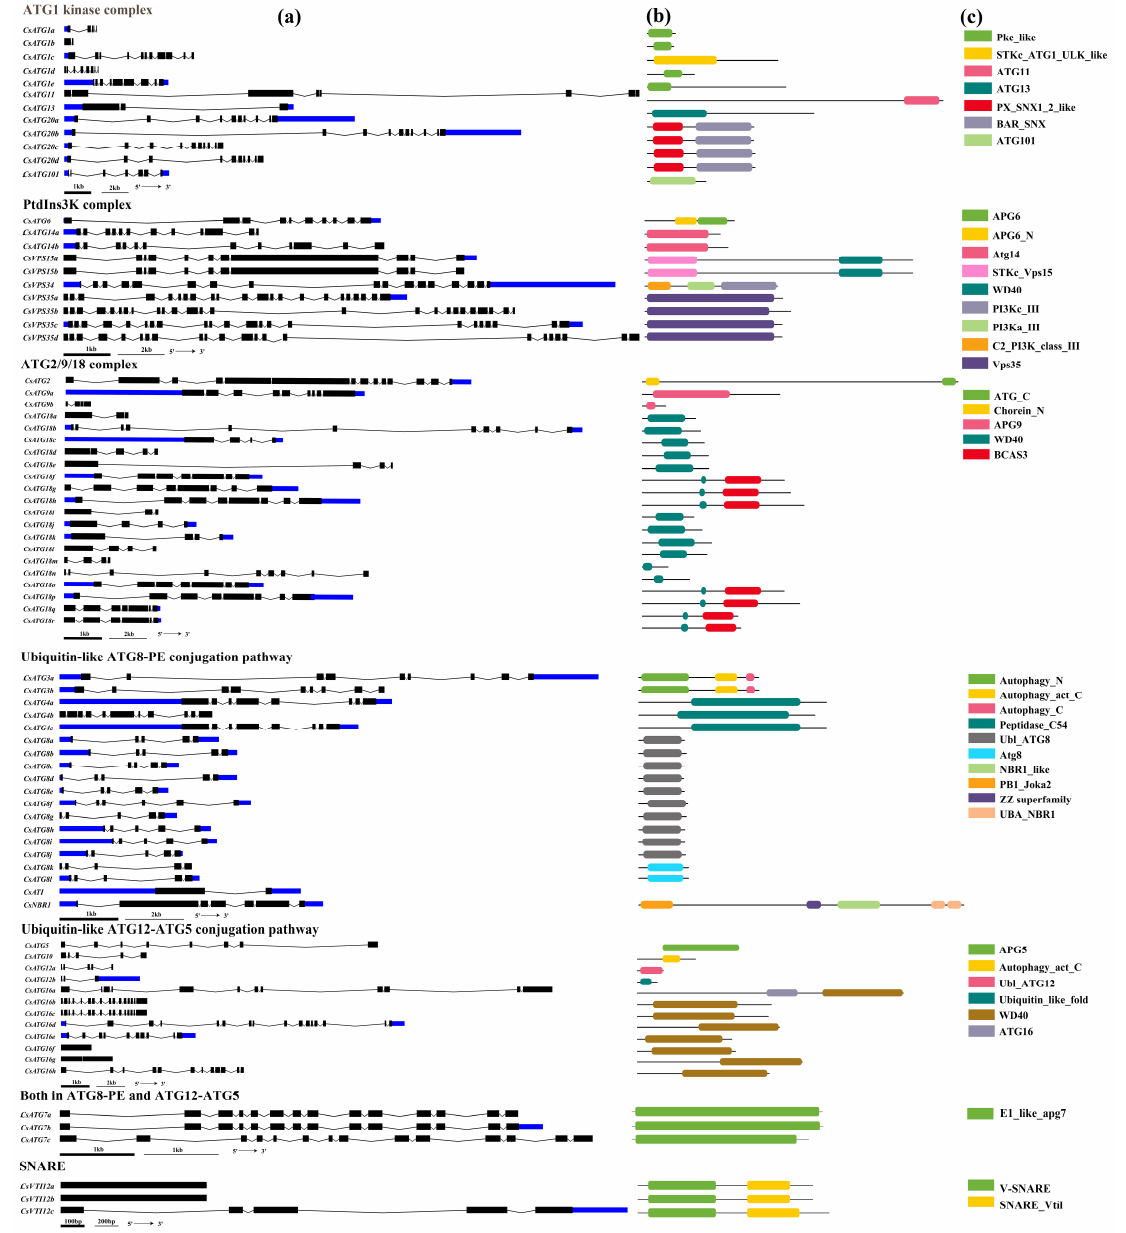
Figure 3. Gene structures and domains of CsATG genes in tea plant. ( a ) The exon-intron structures, with untranslated regions (UTRs) in blue rectangles, exons in black rectangles and introns in thin black lines. Domains of the corresponding genes on the left side ( b ) and ( c ). The 80 CsATG genes were presented according to their functions in autophagy.